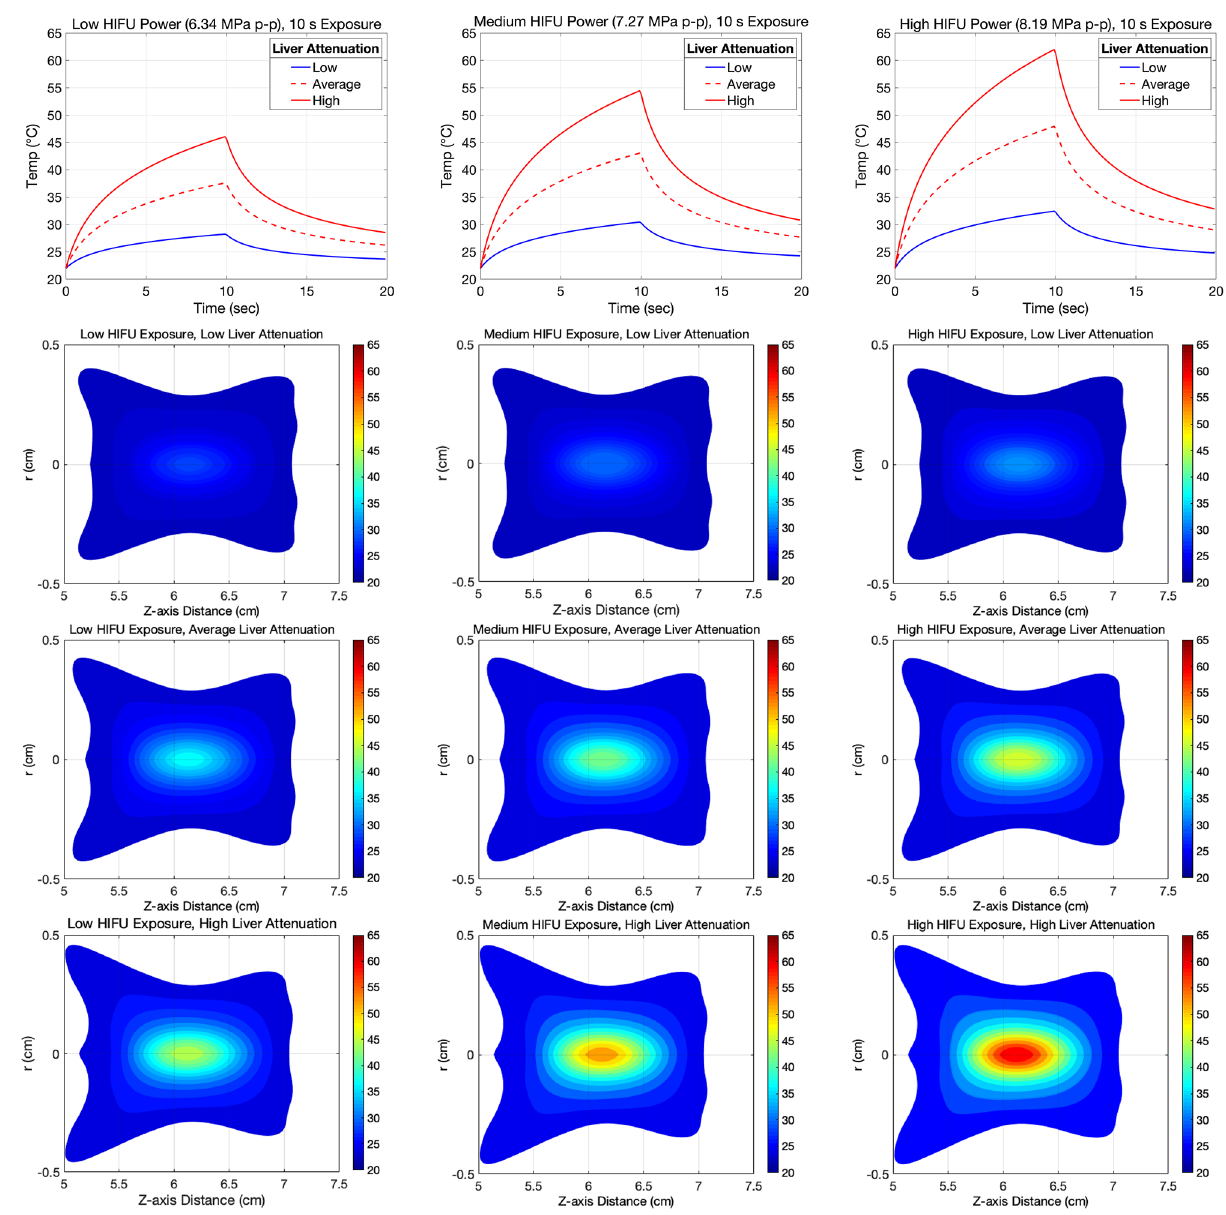
wave 10 s sonication at the transducer’s focal depth of 51.7 mm penetrating 20 mm into tissue. The solid red curve represents high liver attenuation, the dotted red curve average liver attenuation and the blue, low liver attenuation. BOTTOM (Rows 2–4): Temperature maps were simulated using the same parameters at low (row 2), average (row 3) and high (row 4) liver attenuation. Left Column: 6.34 MPa, Middle Column: 7.27 MPa, Right Column: 8.19 MPa peak-to-peak acoustic